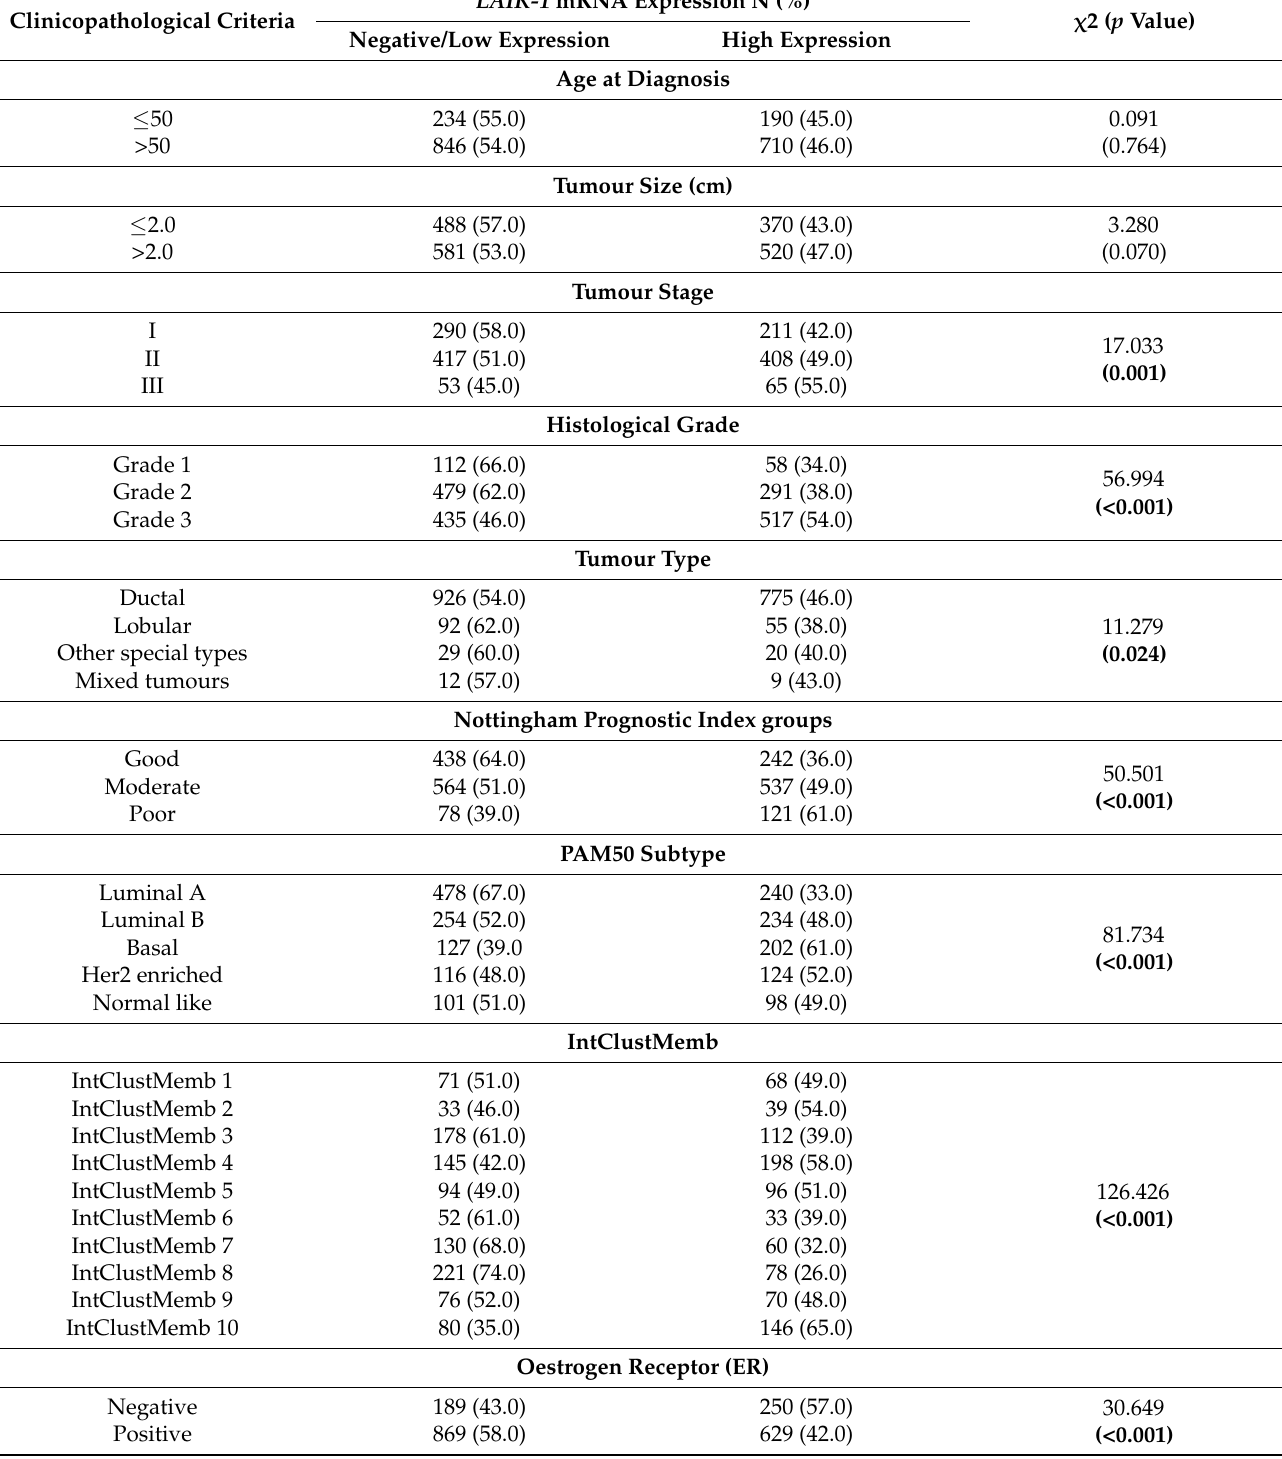
Table 1. Associations between leukocyte-associated immunoglobulin-like receptor-1 ( LAIR-1) mRNA expression and clinicopathological variables in the Molecular Taxonomy of Breast Cancer International Consortium (METABRIC) breast cancer